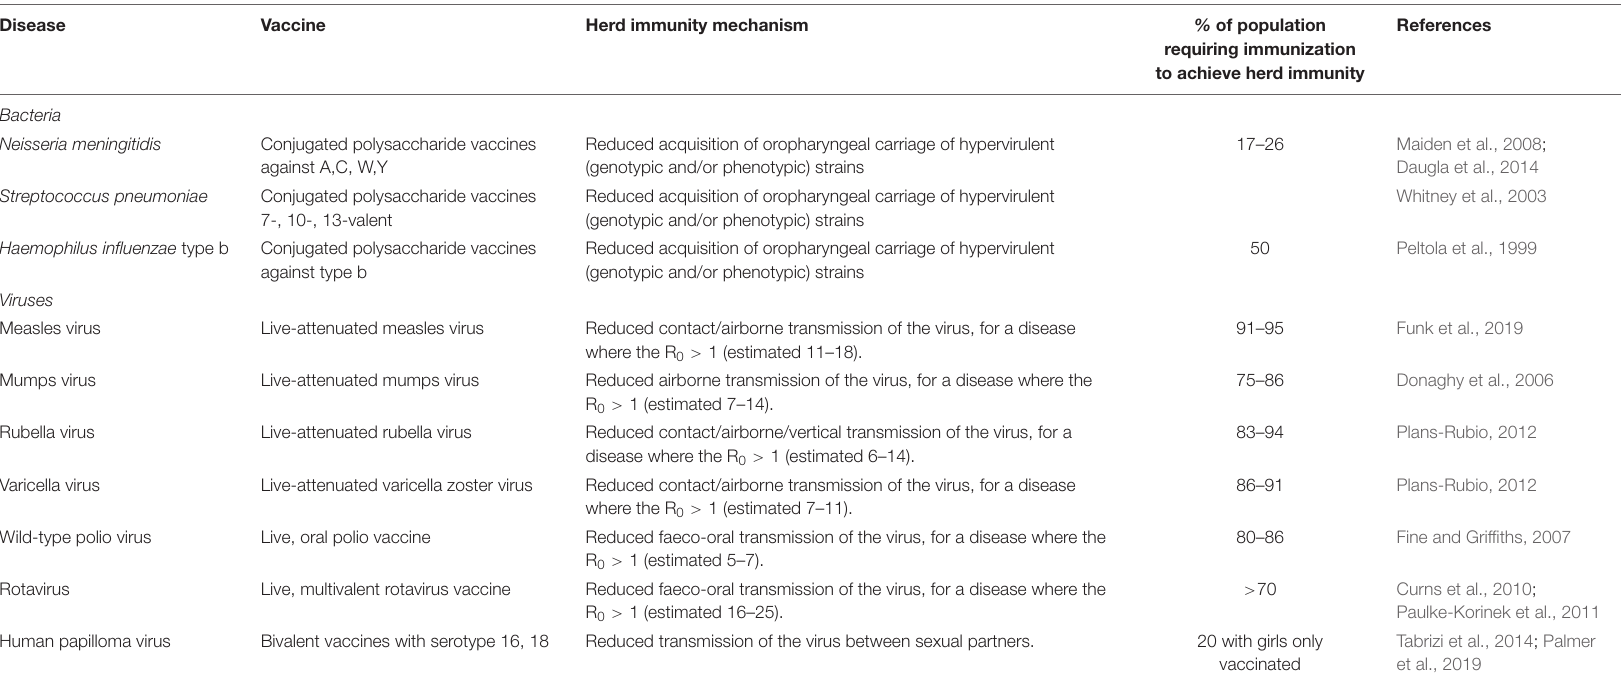
TABLE 2 | Vaccines with the potential to induce herd immunity, with the infectious agent, vaccine type, and thresholds of population vaccination needed for herd immunity (Peltola et al., 1999; Whitney et al., 2003; Donaghy et al., 2006; Fine and Griffiths, 2007; Maiden et al., 2008; Curns et al., 2010; Paulke-Korinek et al., 2011; Plans-Rubio, 2012; Daugla et al., 2014; Tabrizi et al., 2014; Funk et al., 2019; Palmer et al., 2019). Disease Vaccine Herd immunity